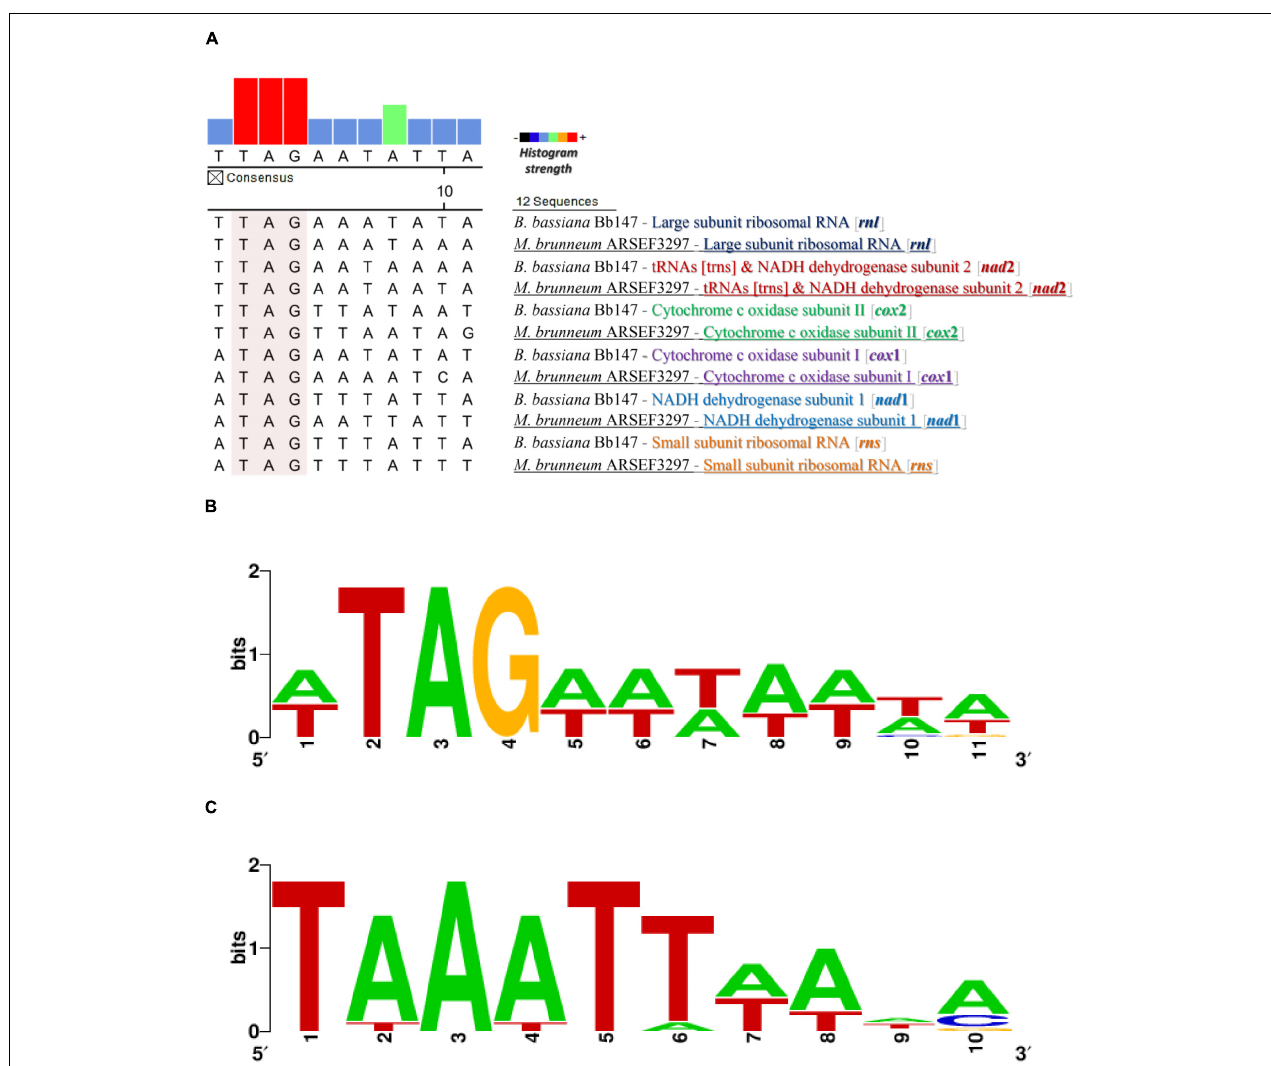
FIGURE 1 | The promoter and transcription termination sequences as found from the in silico analyses. (A) Putative promoter sequence alignment for different mt genes from M. brunneum ARSEF3297 and B. bassiana Bb147. (B) The motif of the putative mt promoter produced by this alignment analysis. (C) The distinct putative mt transcription termination motifs that are located at a variable distance (1–218 nt) downstream from mRNA and rRNA coding regions in the genera Metarhizium and Beauveria